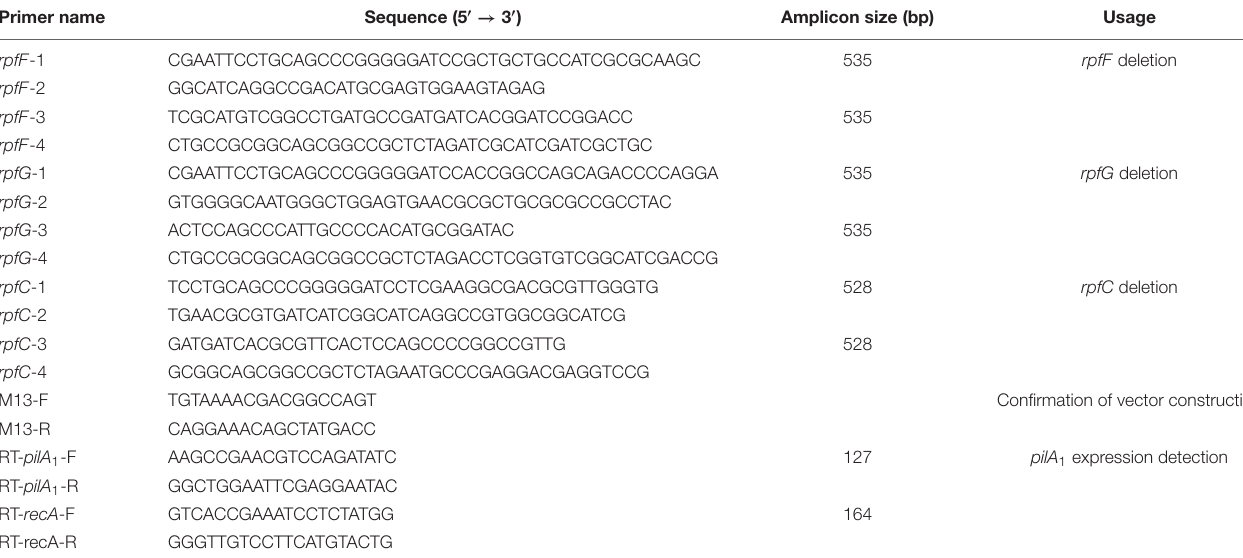
TABLE 2 | Primers used in this